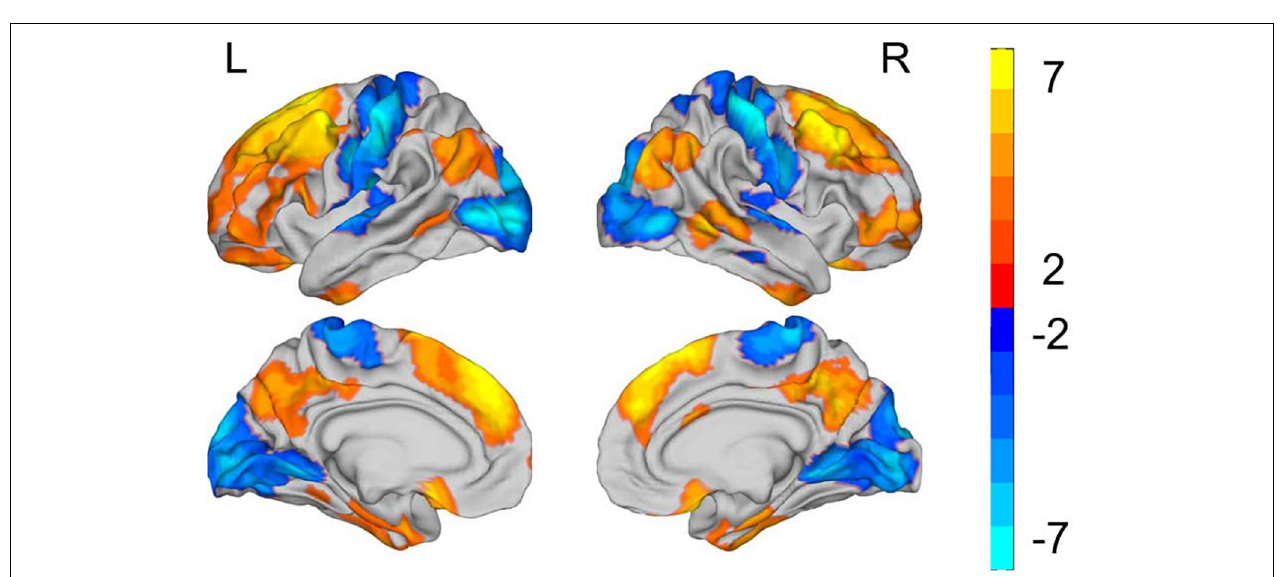
FIGURE 1 | Reduced surface-based 2dReHo in SZ patients compared with HC at the global level ( p < 0.001) across the cortical surface. Global 2dReHo, global mean two-dimensional regional homogeneity. SZ, schizophrenia; HC, healthy control.